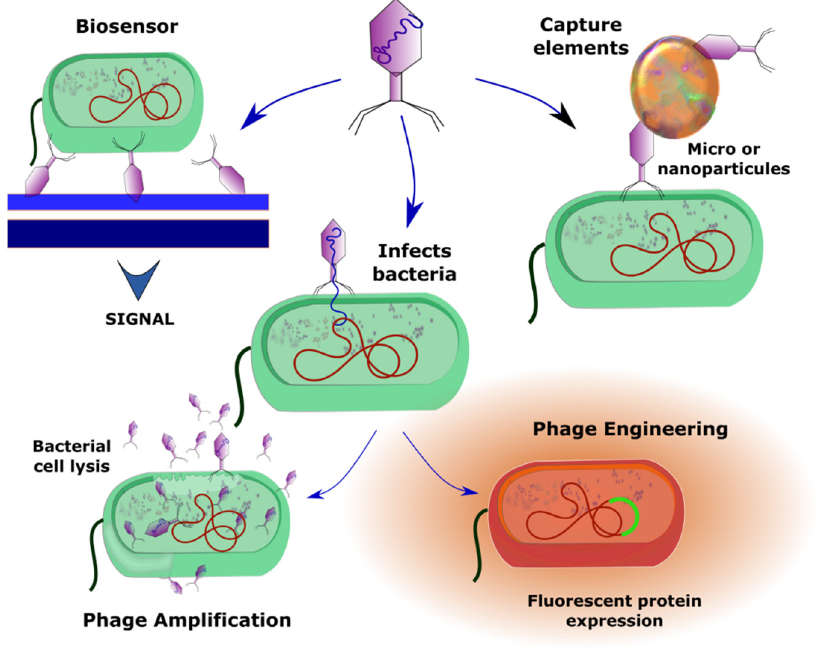
Figure 1. Bacteriophage-based methods for specific bacterial detection. When phages infect cells and multiply using their molecular machinery, their progeny can only be released after cell lysis. Genetically modified phages can infect and facilitate bacterial detection. The figure depicts a phage containing a gene that produces fluorescence and, when inserted into the bacterial genome, using a recombinant tempered phage, it facilitates bacterial detection. Reflected here are also phage uses as capture elements and as bioreceptors in biosensors. Modified from Richter et al. (2018) [41].